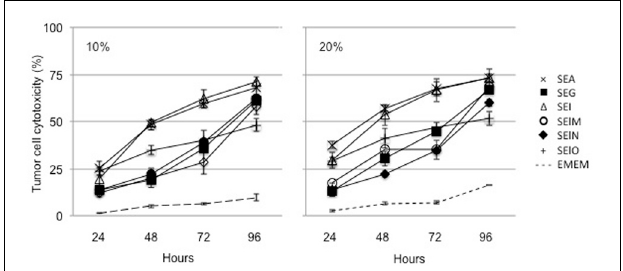
FIGURE 2 | Cytotoxicty of SEA and egcSE-stimulated PBMCs against Hep2 squamous cell carcinoma cells. Supernatants from unstimulated PBMCs, SEA-, SEG-, SEI-, SElM-, SElN-, or SElO-stimulated PBMCs were added at 10% or 20% vol/vol to Hep2 squamous cell carcinoma cell culture. After 1–4 days, cell viability was evaluated by MTT asays. Results are shown as the mean ± SEM for each point ( n = 3 independent